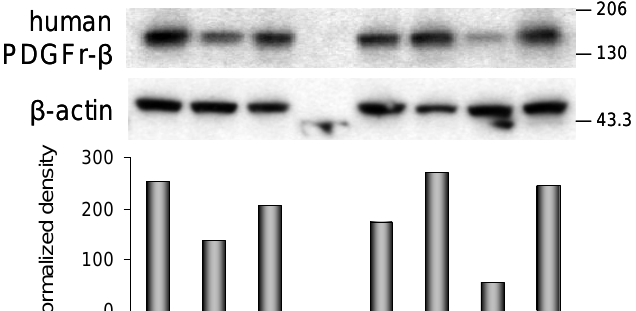
Figure 3. Activation of human PDGFr-β signaling pathway in response to imatininb and radiation injury. Expression of human PDGFr-β. Western immunoblotting analyses with mouse monoclonal anti-human PDGFr-β monoclonal antibodies ab10847 to determine expression of human PDGFr-β in response to various treatments. The bands were detected with ImmunoPure goat anti-mouse IgG (H + L), peroxidase conjugated antibodies 31430. The lower panel is the same membrane probed with rabbit anti-β-actin mAb 13E5. The bar graph represents protein band intensity normalized to the protein load as measured by the intensity of β-actin band using